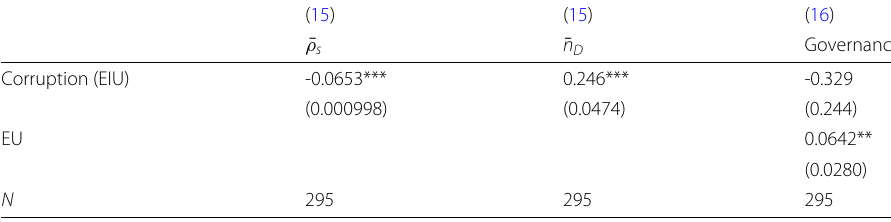
Table 4 Estimates using the EIU indicator of corruption among public